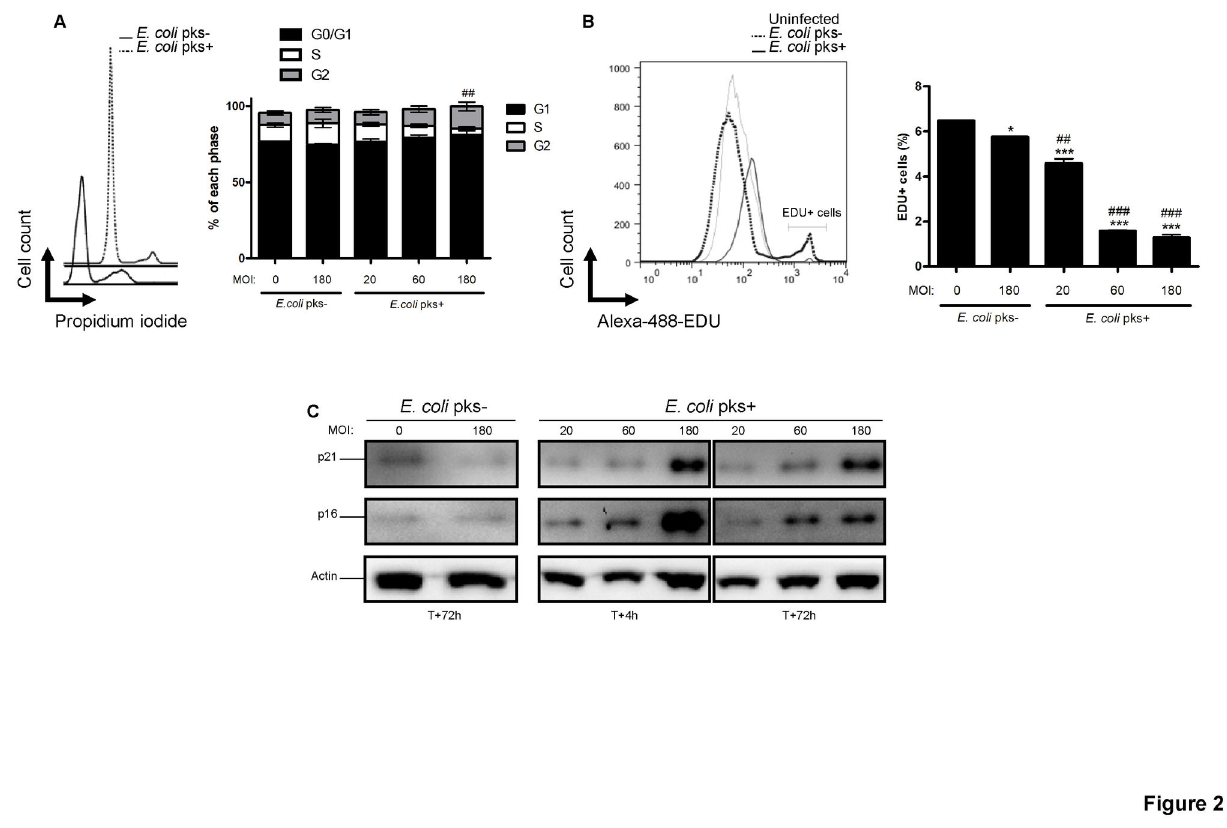
Figure 2. Permanent cell-cycle arrest and increased cell-cycle inhibitors expression in IMR-90 cells infected with pks + E. coli. (A) Cell-cycle distribution was analyzed by flow cytometry 3 days after infection. (B) 3 days after the infection the cells were incubated with EdU for 2 hours and its incorporation in S-phase cells was analyzed by flow cytometry. (C) Western blot analysis of p21 and p16 protein content in IMR-90 cells 4h, 1 and 6 days after infection. Actin was probed as a protein loading control. Results represent the mean and SEM of two independent experiments, one-way ANOVA with Bonferroni’s multiple comparison test; *P<0.05, ***P<0.001 comparing infected and uninfected groups; # #P<0.01, # # #P<0.001 comparing pks + and pks -